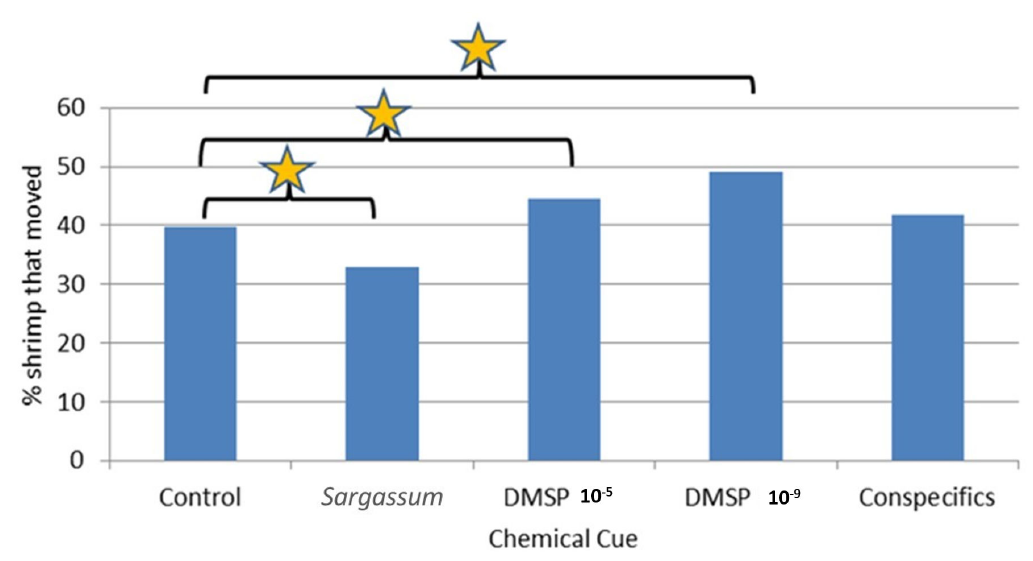
Figure 4. Number of Latreutes fucorum shrimp that moved out of area C in the Y-maze for the control, Sargassum , DMSP 10 − 5 M, DMSP 10 − 9 M, and conspecific cue trials (binomial test; Sargassum , p = 0.03; DMSP 10 − 5 M, p = 0.05; DMSP 10 − 9 M, p = 0.01; and conspecifics, p = 0.08). Star/bracket indicates significant differences between indicated paired